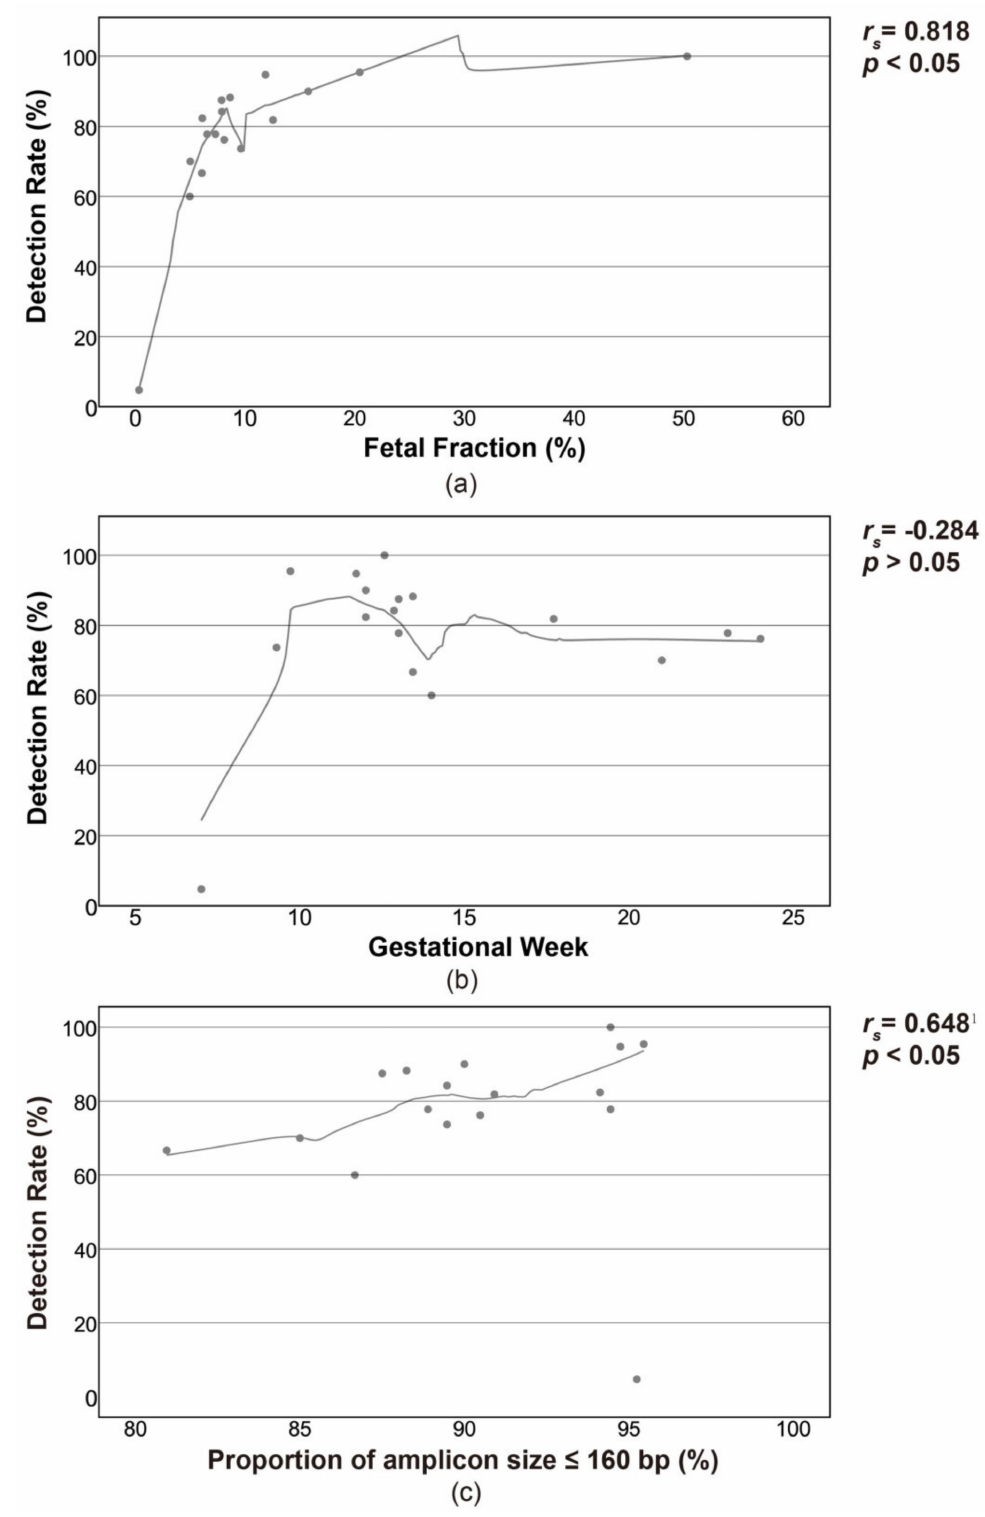
Figure 3. Correlation between detection rate for ePIAs and fetal fraction ( a ), gestational week ( b ) and amplicon size ( c ). 1 An outlier was excluded from statistical